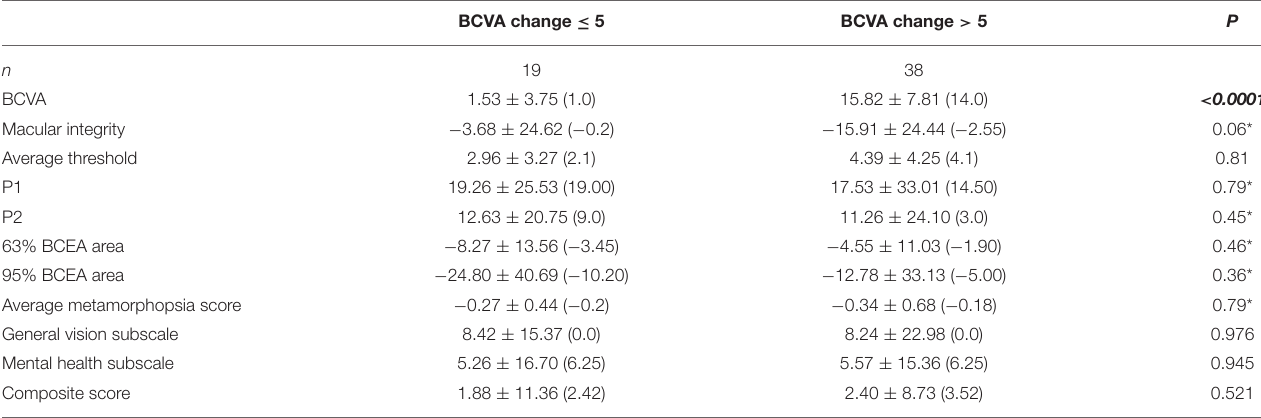
TABLE 5 | Visual function and VR-QoL changes in BCVA improved subgroup and BCVA sustained